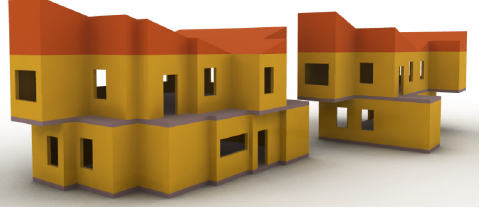
Figure 12: Residential freeform buildings.